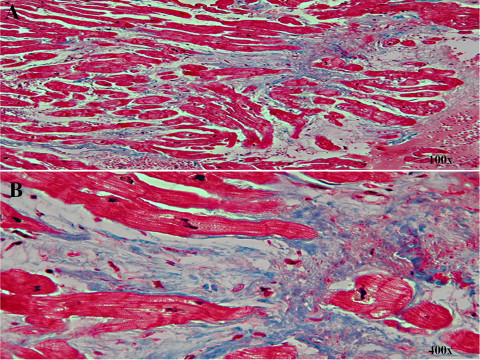
Endomyocardial biopsy of the left ventricle (hematoxylin and eosin stain) showing the myocardial fibrosis (100×, 400×), along with the cardiac myocytes.